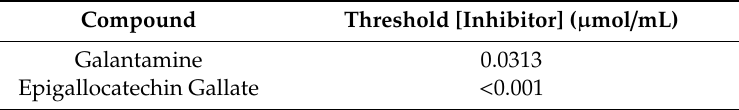
Table 10. Threshold concentrations required for BuChE inhibition.